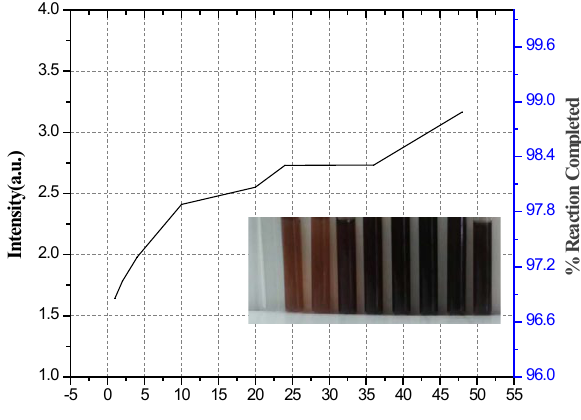
Fig.1 (a). SAgNPs: Intensity graph of reaction mixture containing aqueous 3mM AgNO 3 solution treated with Stem Water extract (SWE) versus time (hour) showing that the 90% of SNPs biosynthesis completed within 2 hr. Inset: increase in the color intensity of the reaction mixture with time.